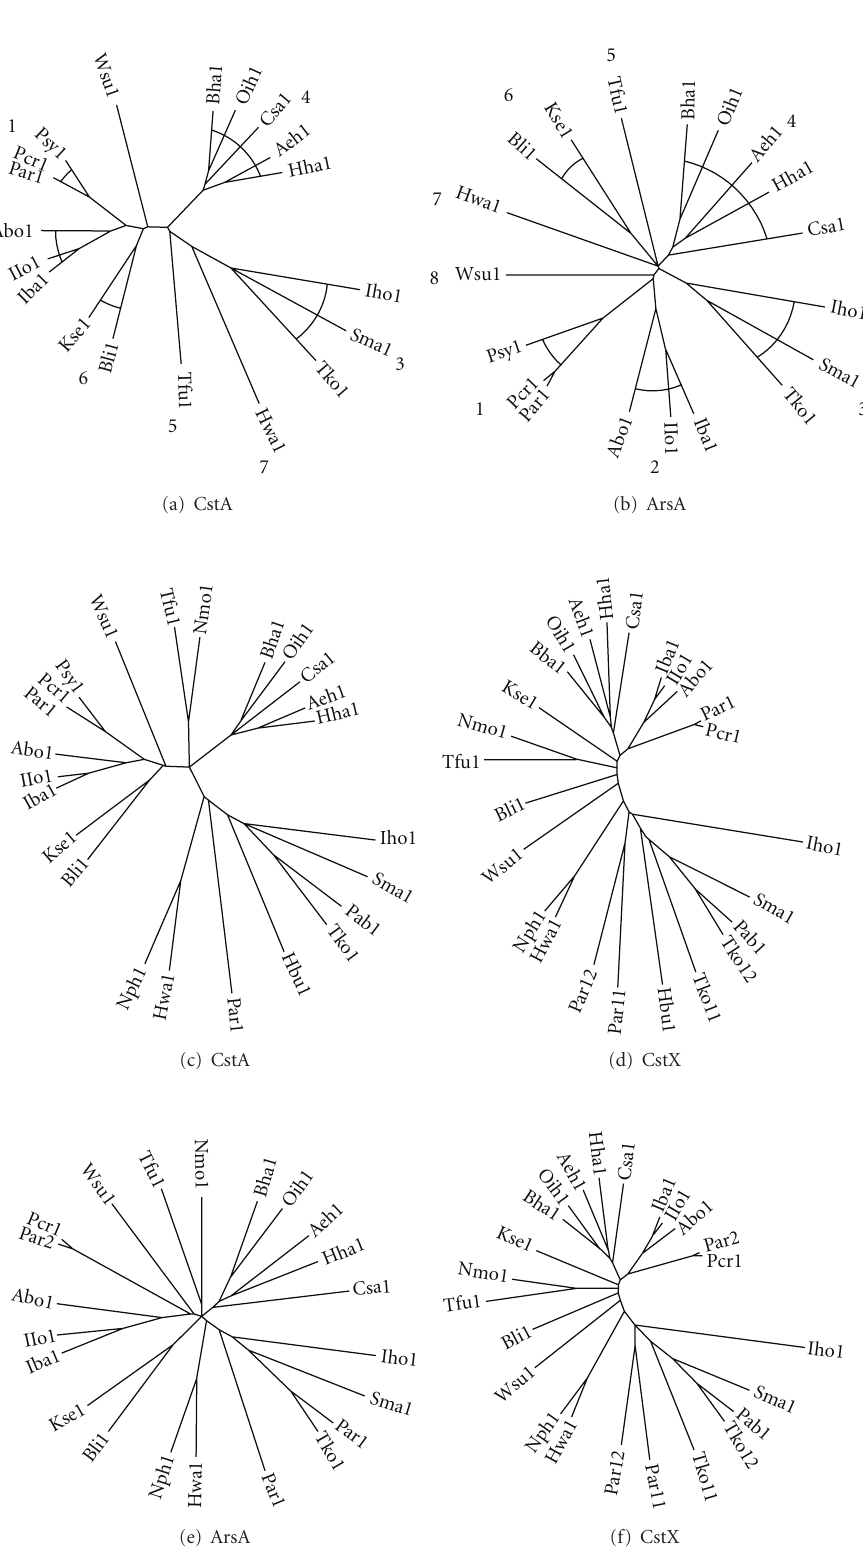
Figure 2: Phylogenetic trees showing the coevolution of (a) CstA and (b) ArsA homologues, (c) CstA and (d) CstX homologues, and (e) ArsA and (f) CstX homologues, each pair being encoded within the same operons. The methodology was as described in Figure 1. Cluster numbers are assigned counterclockwise in (b) and retained in (a). Paralogues are distinguished with a second digit, either 1 or 2, in the protein